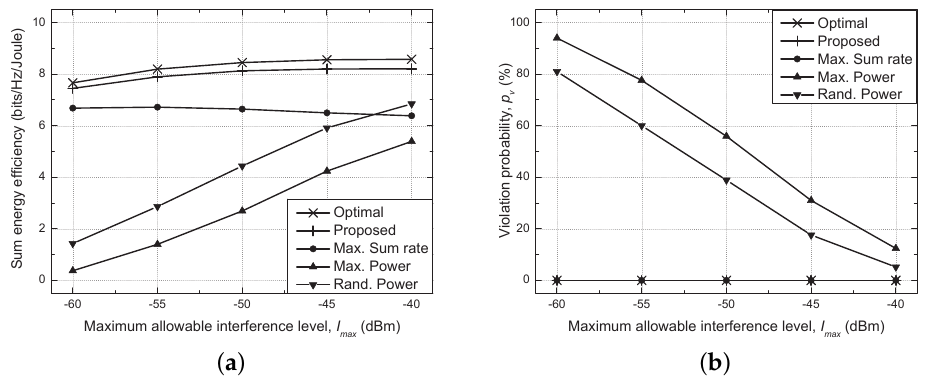
Figure 4. Performance comparison versus the maximum allowable interference level ( I max ). ( a ) Sum energy efficiency vs. I max . ( b ) Violation probability vs. I max .